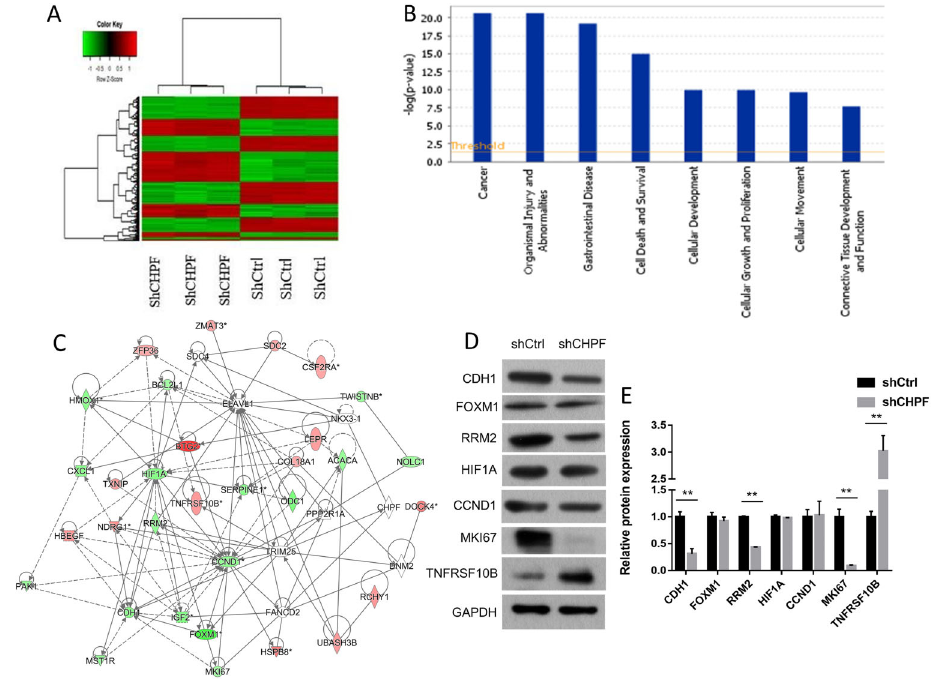
Figure 7. Effect of chondroitin polymerizing factor ( CHPF ) on global gene expression. A , Heatmap representation of 635 differentially expressed genes (DEGs) in A549 cells infected with sh CHPF or shCtrl. P o 0.05 and fold-change 4 2 (red: upregulated genes; green: downregulated genes). B , Functional pathway enrichment of the DEGs was analyzed via Ingenuity Pathway Analysis. The x-axis represents the pathway. Statistical signi fi cance is shown on the y-axis and represents the inverse log of the P-value. C , The network was built on the basis of microarray data of lung cancer cells. Red represents upregulation and green represents downregulation. D , Western blotting analysis was applied to evaluate the expression of CDH1 , FOXM1, RRM2 , HIF1A , CCND1 , MKI67 , and TNFRSF10B in sh CHPF and shCtrl lung cancer cells. Data are reported as means ± SD. **P o 0.01 (Student ’ s t